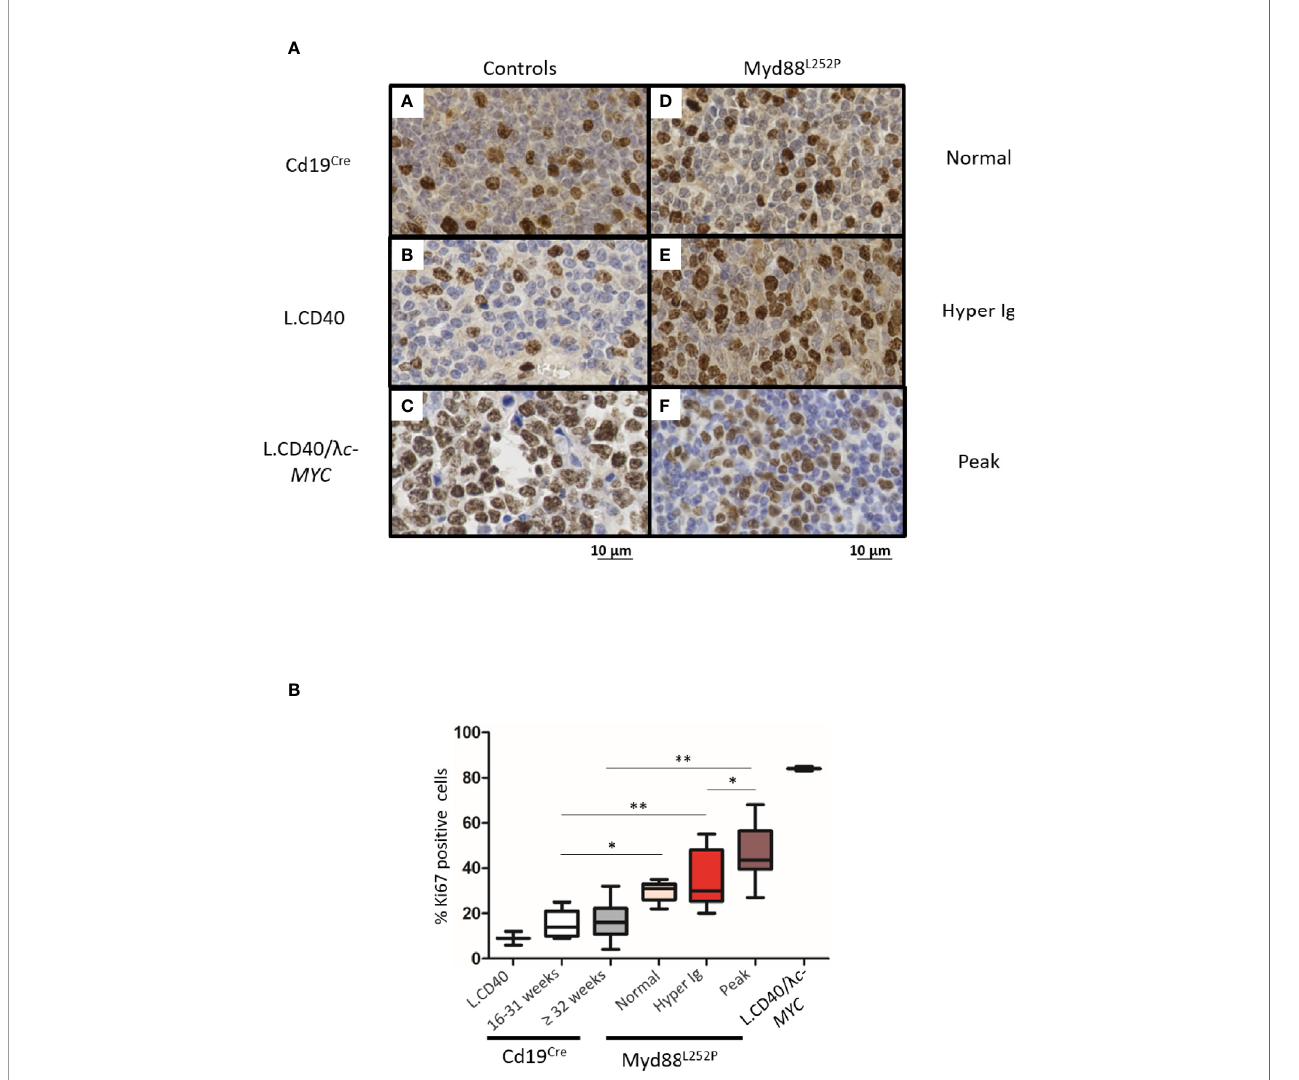
FIGURE 7 | Intermediate increase in Myd88 L252P tumor proliferation rate. (A) Examples of Ki67 labeling in spleen sections from three controls (panels A-C) and three Myd88 L252P mice (panels D-F, n=28). Controls were Cd19 Cre LMCs (panel A, n = 5 for 16-31 week-old mice and n = 8 for ≥ 32 week-old mice), L.CD40 mice (panel B) with indolent splenic lymphomas of marginal zone B-cells (n=2), as well as L.CD40/ l c-Myc mice (panel C, n=2) with a ABC-DLBCL lymphomas (24, 28). The three Myd88 L252P tumors (panels D-F) are one representative example of each group de fi ned according the SPE pro fi le (normal n = 5, hyper Ig n = 8 and Ig peak n = 15). Here, L.CD40 mice were used as a model of indolent B-cell lymphoma with a low proliferation index while L.CD40/ l c-Myc mice were a model of aggressive B- cell lymphoma with a high proliferation index. (B) Quanti fi cation of Ki67 labeling. Box plots represent the median and quartile of percentages of Ki67 positive